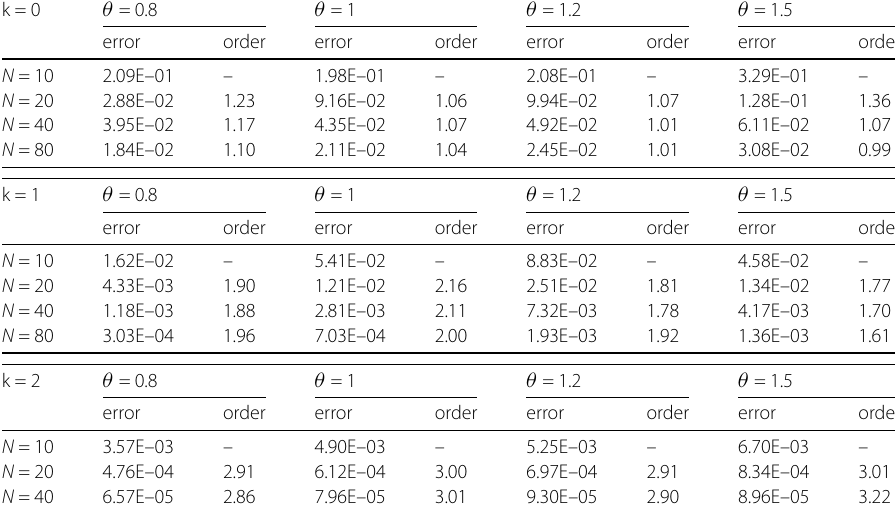
Table 2 The L 2 -norm error estimates at T =